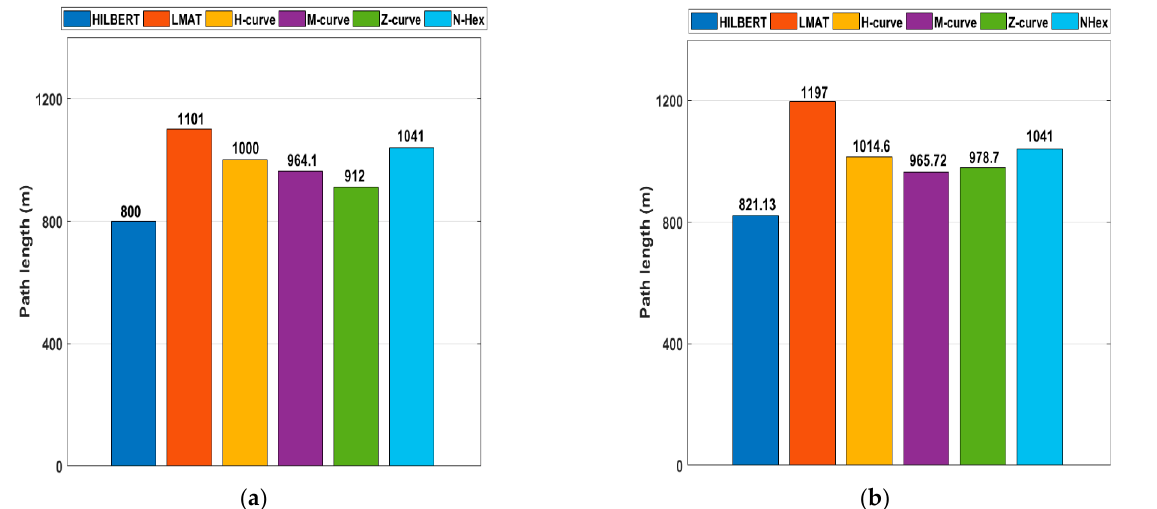
Figure 19. The path length for the different mobility models ( a ) obstacle-free ( b ) obstacle presence.